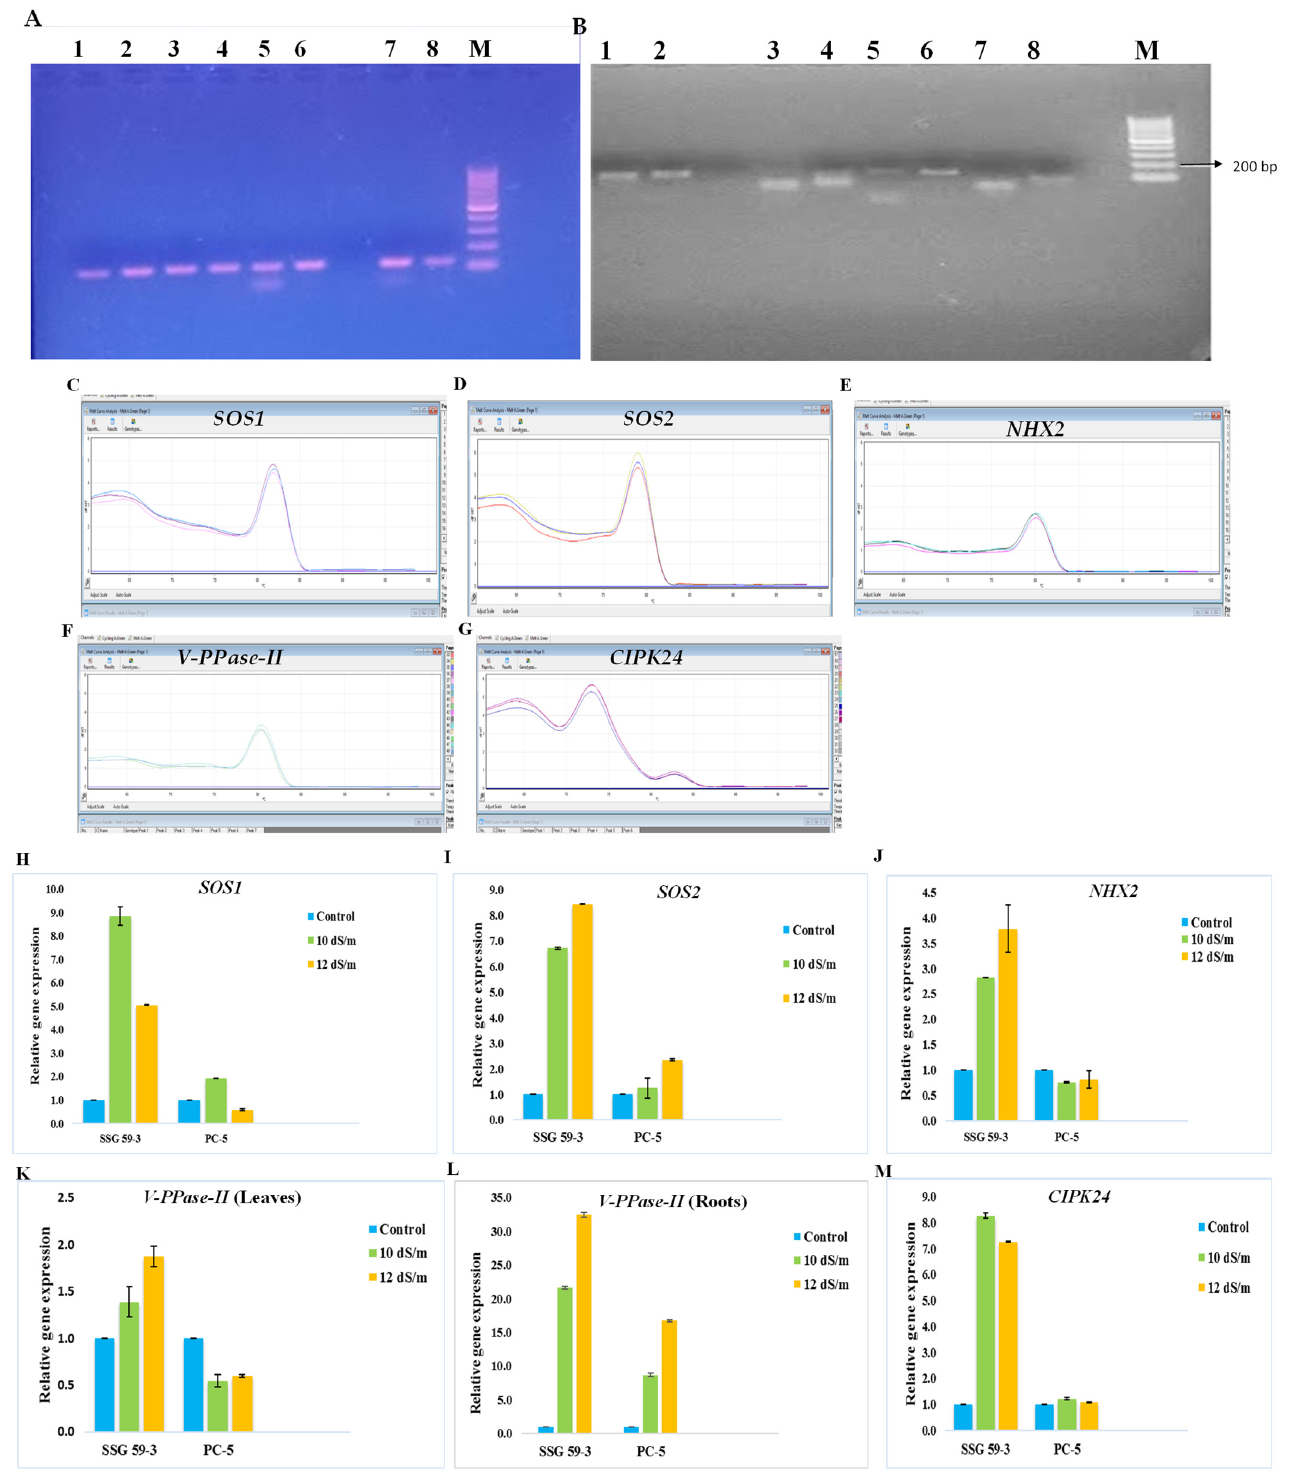
Figure 12. Agarose gel: ( A ) mRNA of salt stress-responsive genes (1: SOS1 ; 2: SOS2 ; 3. NHX2 ; 4: V-PPase-II (leaves); 5: V- PPase-II (roots); 6: CIPK24 ; 7: Act1 ; 8: PP2A ; L: ladder)), ( B ) PCR products of the expected sizes ( ≤ 200 bp; 1: SOS1 ; 2: SOS2 ; 3. NHX2 ; 4: V-PPase-II (leaves); 5: V-PPase-II (roots); 6: CIPK24 ; 7: Act1 ; 8: PP2A ; L: ladder)), ( C – G ) melt/dissociation curve of salt stress-responsive genes under saline conditions, ( H – M ) the expression levels of stress-related ion transporter genes based on qPCR. The PP2A gene was used as the reference gene/internal control. Data are shown as mean ± S.D. ( n =